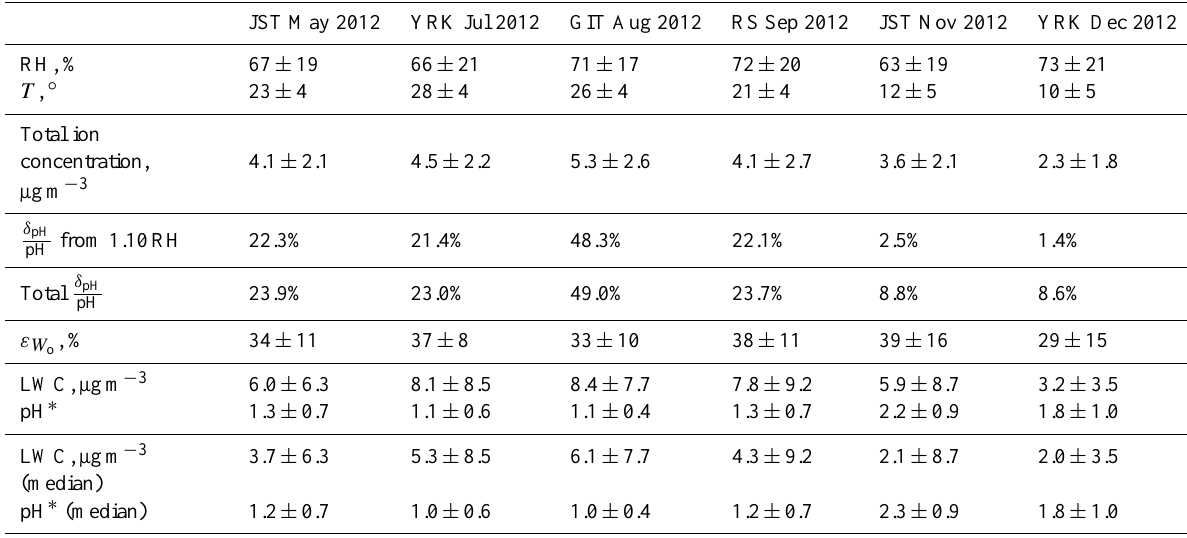
Table 3. Water and pH prediction for SCAPE sites. Means and SDs are listed, if not specified. Total ion concentration is counted as the sum of AMS inorganics (third row). ε W is the mass fraction of W o (fifth o